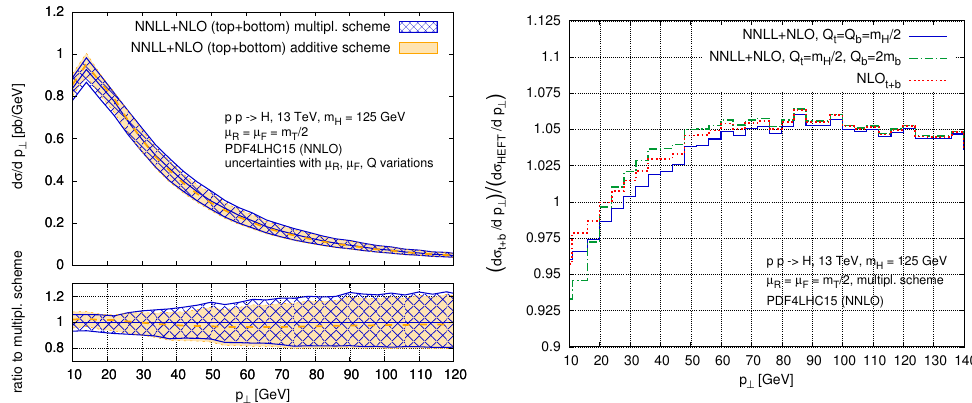
Figure 4 . Left plot: comparison for the full distribution between the additive scheme with Q t = Q b = m H = 2, and the default multiplicative scheme with Q t = Q b = m H = 2. Right plot: ratio of the full distribution with di(cid:11)erent accuracies to the HEFT prediction based on the same accuracy. In the right plot all matched results are obtained within the multiplicative matching scheme.